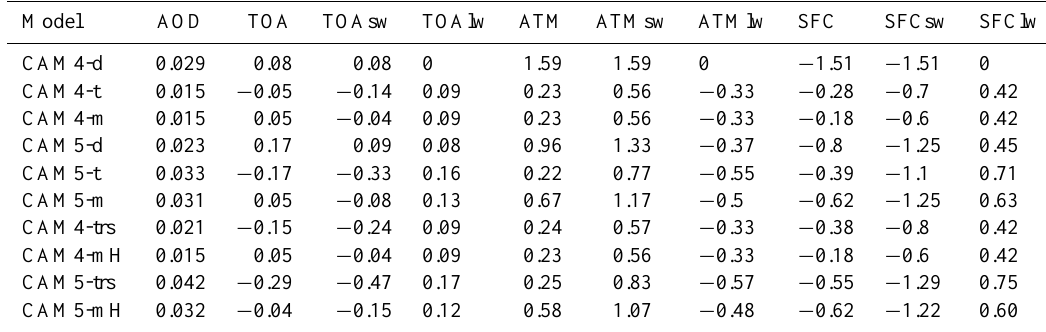
Table 8a. Simulated annual average global all-sky radiative forcing.